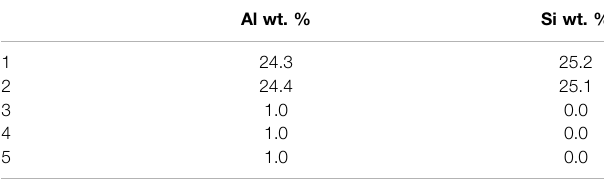
TABLE 5 | Compositions of alumina and silica across the line